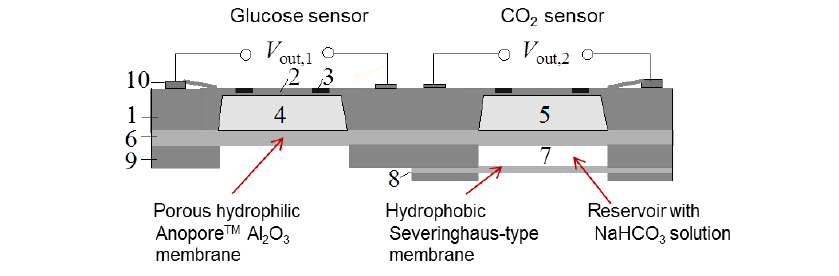
Figure 2. Schematic setup of a hydrogel-based sensor array comprising a glucose and a CO 2